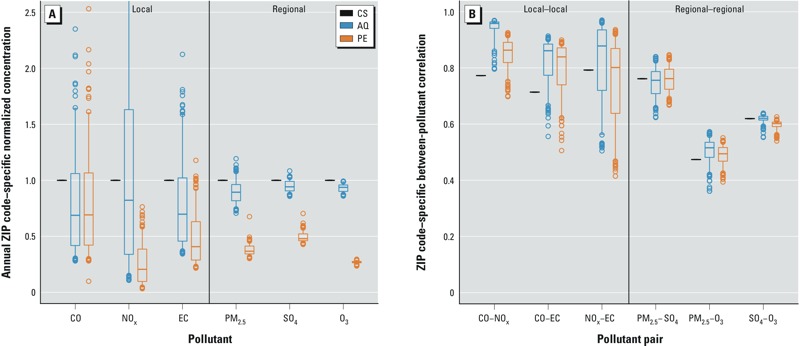
Relationships between the three ZIP code–specific exposure metrics. (A) Normalized exposure metrics for local and regional pollutants (see Supplemental Material, Figure S2A, for full extent of data and outliers). (B) Between-pollutant correlations of exposure for local–local and regional–regional pollutant pairs (see Supplemental Material, Figure S2B, for local–regional pollutant pairs). The bottoms and tops of boxes represent 25th and 75th percentiles, lines within boxes indicate the median, and the whiskers represent 5th and 95th percentiles; n = 193.